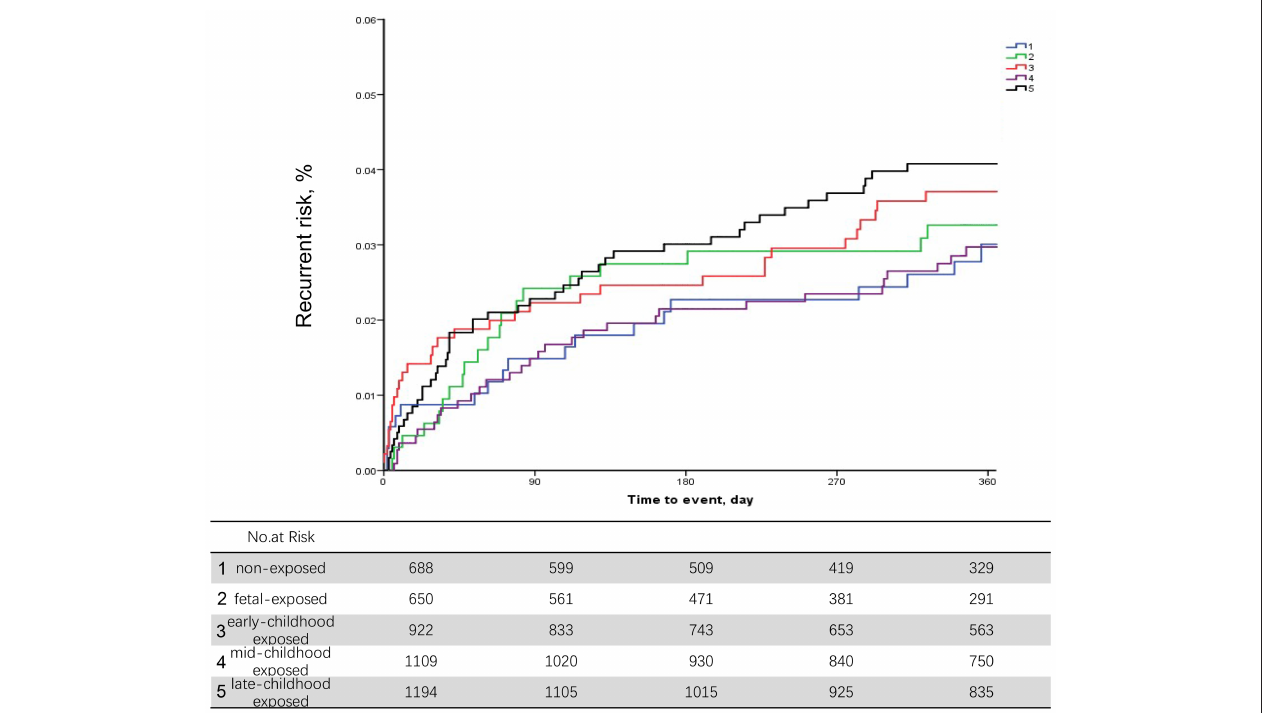
FIGURE 2 | Unadjusted Kaplan–Meier curves for stroke recurrence in non-exposed, fetal exposed, early-childhood exposed, mid-childhood exposed, and late-childhood exposed patients.